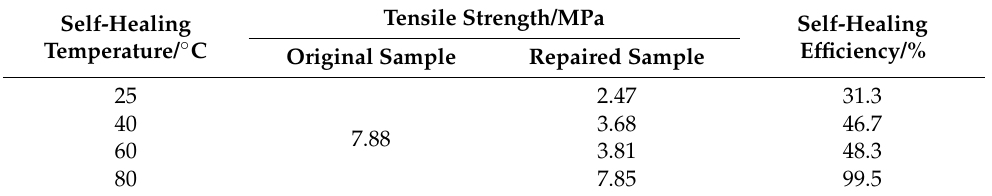
Table 4. Elastic modulus and yield stress of PUSS-6 after self-repair at different temperatures.